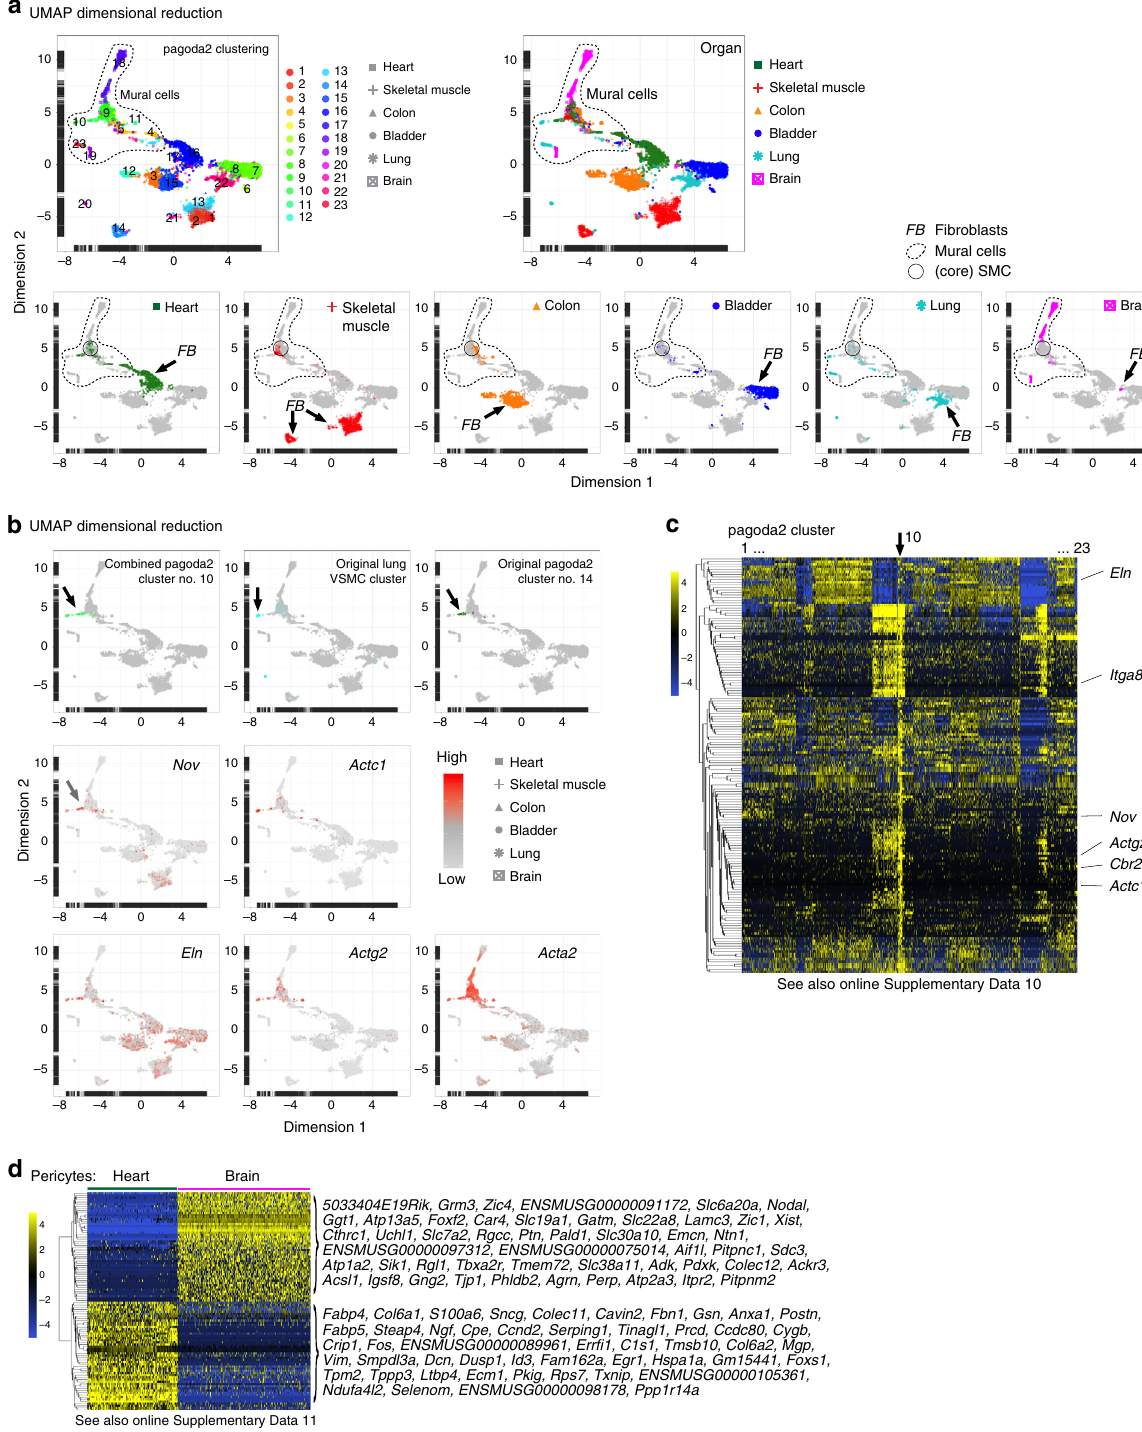
Fig. 8 Heterogeneity analysis in additional organs. a UMAP visualization of the combined analysis of the heart, skeletal muscle, colon, and bladder together with the mesenchymal cells of the brain and lung datasets 11 , color coded for pagoda2 clusters (upper left) or the organ of origin (upper right). Cell clouds containing mural cells and core SMC are indicated (lower panel). b UMAP visualization highlighting cells of pagoda2 cluster 10 (upper left), cells of the lung VSMC cluster (upper middle), cells of the original complete dataset cluster 14 (upper right), or expression levels of cluster 10 of the combined analysis enriched genes ( Nov , Actc1 , Eln , and Actg2 ) as well as Acta2 (gray, low; red, high). c Expression heat map (blue, low; yellow, high) of enriched genes in cluster 10 of the combined analysis (see also Online Supplementary Data 10). d Expression heat map (blue, low; yellow, high) of each 50 most differentially expressed genes in heart vs. brain pericytes (see also Online Supplementary Data